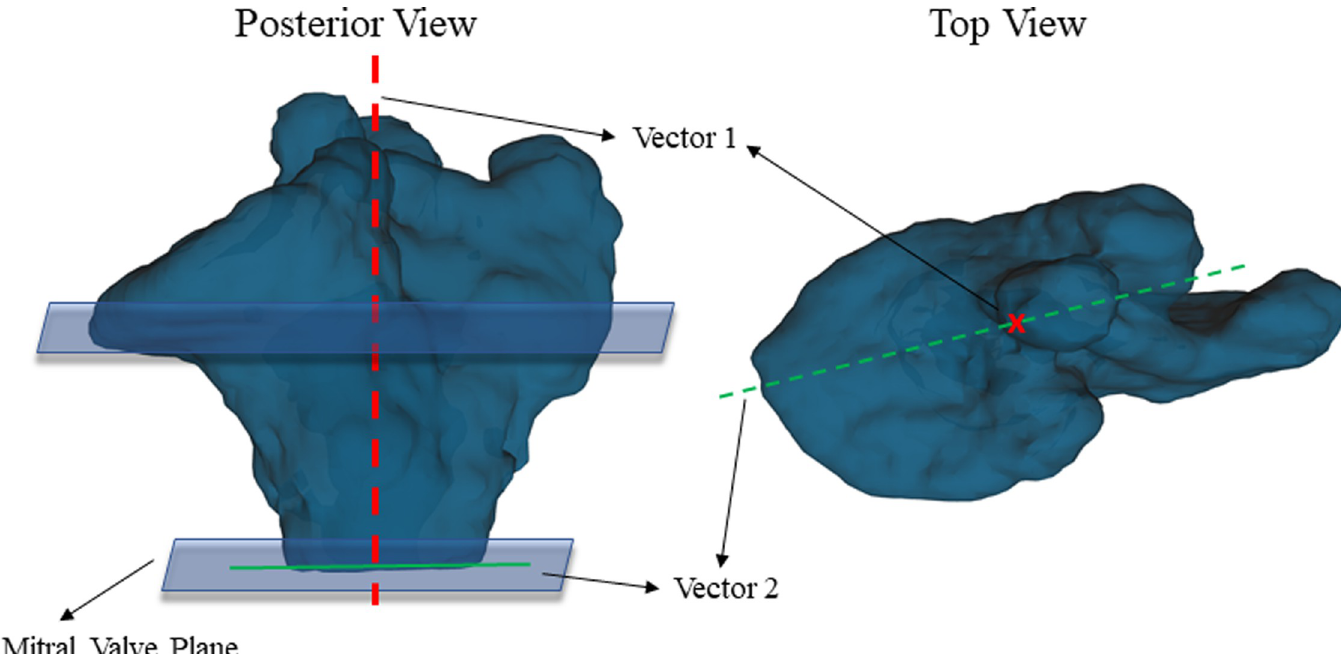
Fig 3. Reference vectors for comparing the fiber direction s between different regions of the left atrium and across different animals. Vector 1 (shown in red) is perpendicular to the mitral valve plane and vector 2 (shown in green) lays on the plane parallel to the mitral valve and starts from the midpoint between pulmonary veins to the tip of the appendage.